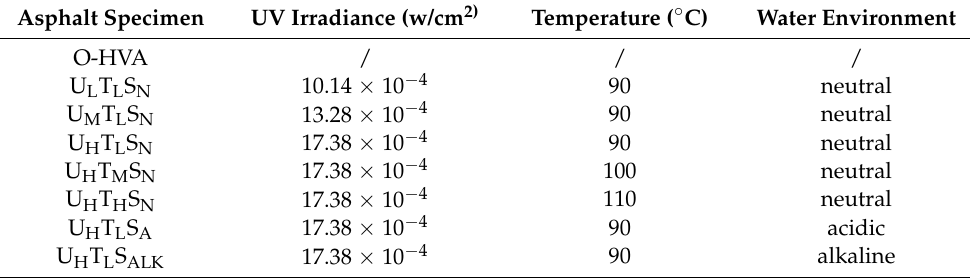
Table 3. Aging program.